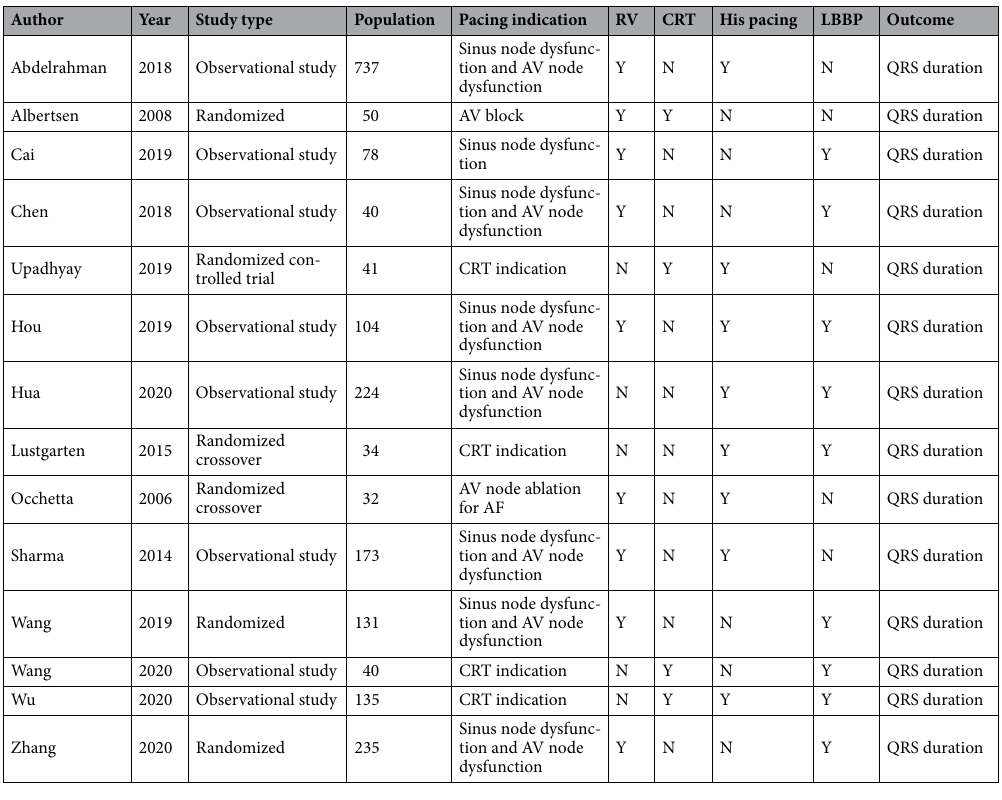
Table 1. Study characteristic.